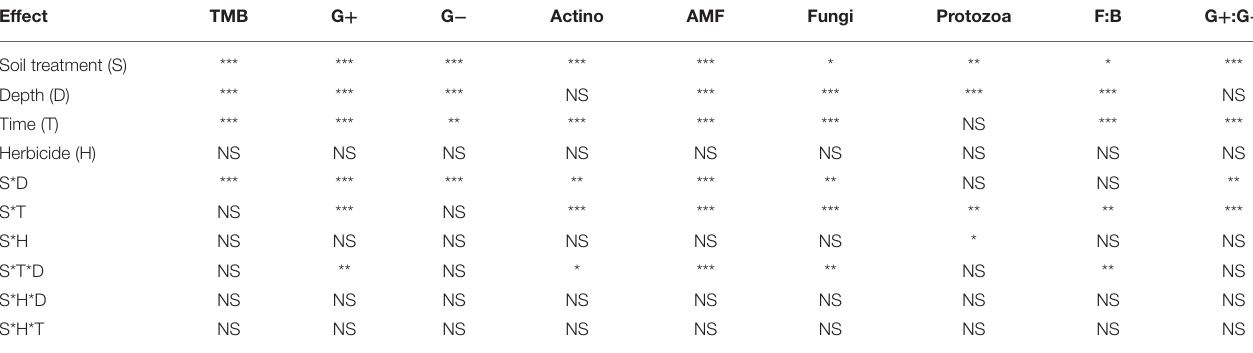
TABLE 1 | Analysis of variance of the effects of soil treatment, soil depth, sampling time, and herbicide application, and their two-way and three-way interactions on microbial group concentrations.